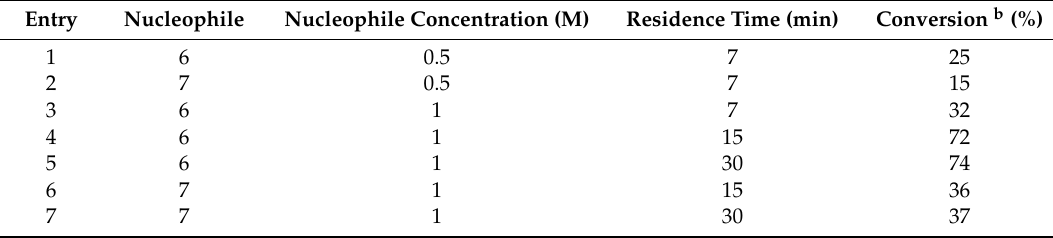
Table 2. Synthesis of esters 9 and 10 catalyzed by immobilised MsAcT a